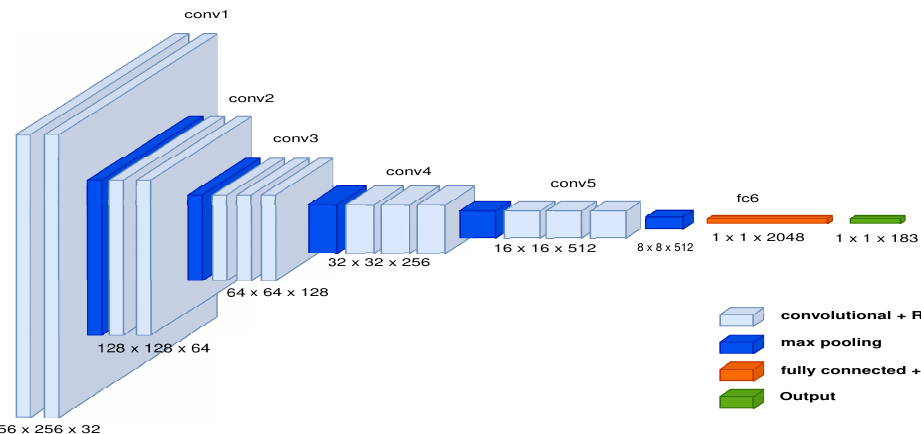
Figure 9. Features of the DCNN model to extract characteristic